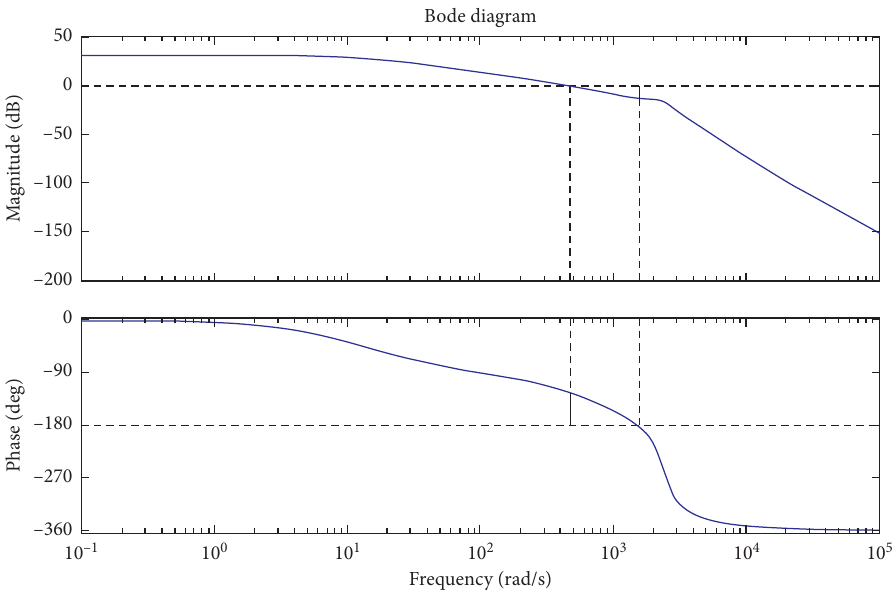
Figure 13: The Bode diagram of the EHSLS after optimization.